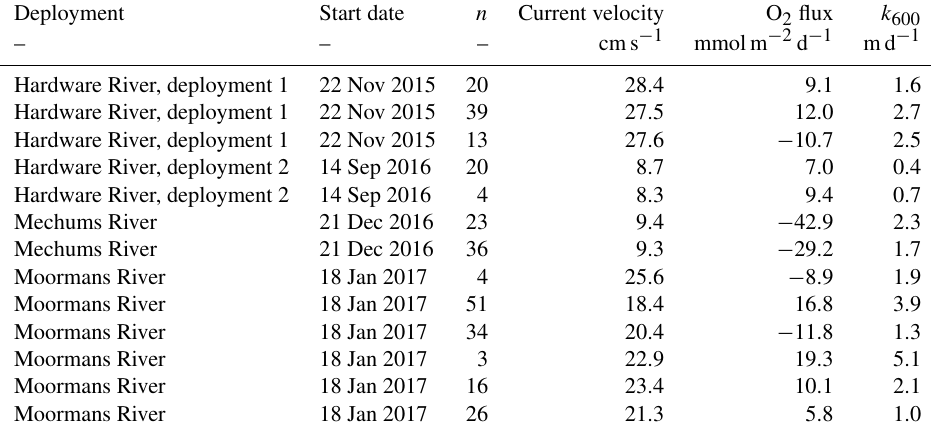
Table 1. Representative standard gas exchange coefficients ( k 600 ) along with current velocity and O 2 flux for four deployments at three different sites. The third column ( n) specifies the number of 15min time intervals included in the averages. Values from the last deployment (Moormans River) are depicted in Figs. 2 and